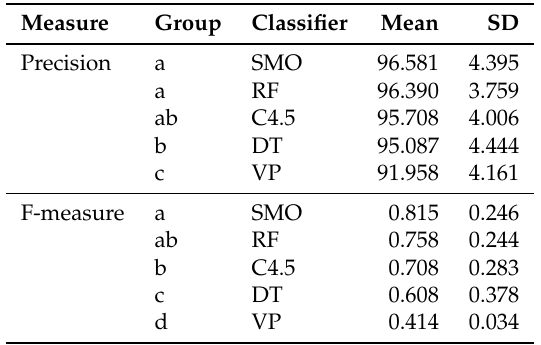
Table 9. Duncan test’s groups of classifiers by the percentage of correctly-classified instances.